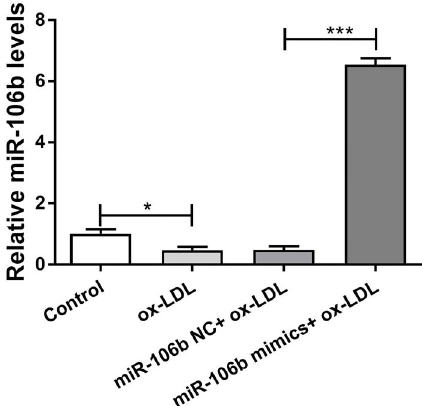
Figure 1. Expression level of microRNA-106b in oxidized-low- density lipoproteins (ox-LDL)-induced human aortic endothelial cells. Data are reported as means ± SD. *P o 0.05, ***P o 0.001 (ANOVA). NC: negative control.